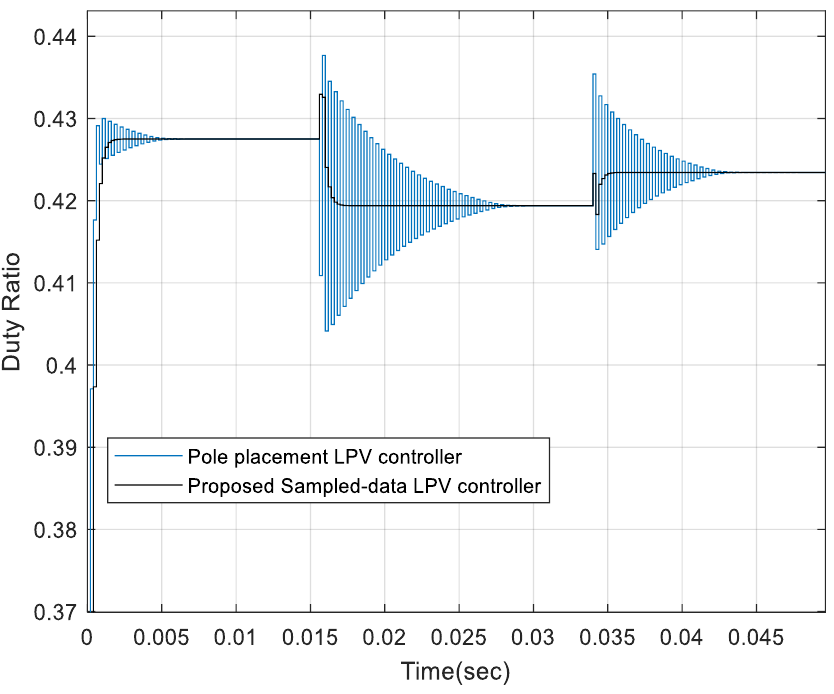
Figure 3. Manipulated duty cycle of the buck converter for embedded PWM control duty ratio in the presence of load variations ( T = 0.0005 s).